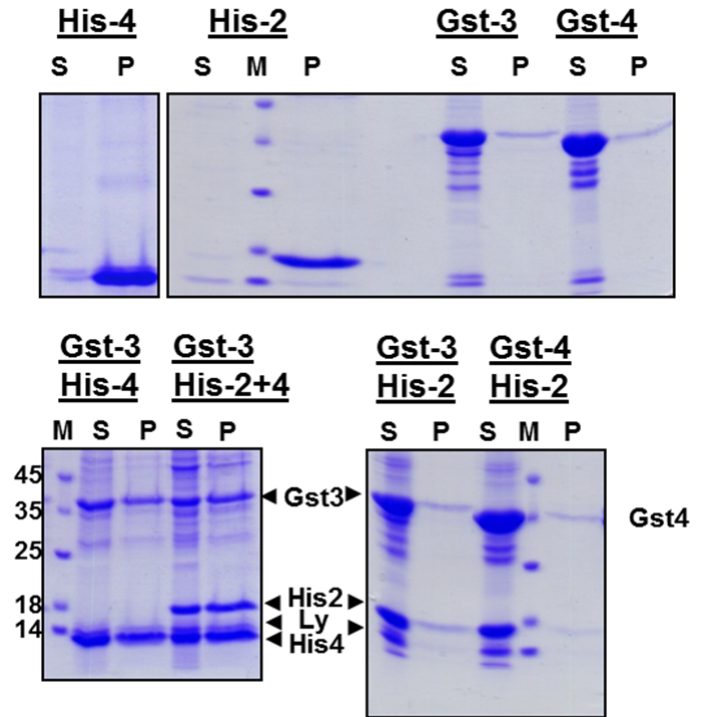
Figure 2. Refolding of EAV proteins during dialysis of urea-extracts of inclusion bodies. Upper panel: Dialysis of individual EAV-proteins. Lower panel: Combined dialysis of the indicated combinations of EAV-proteins. Inclusion bodies were resuspended in denaturating buffer. After centrifugation the resulting supernatants were dialyzed against buffer with decreasing urea concentration and finally against physiological buffer. The dialysate was then centrifuged and aliquots of the supernatant (S) and of the pellet (P) were analyzed by SDS-PAGE under reducing conditions and Coomassie-staining. M: molecular mass marker as indicated, Ly: Lysozyme. Due to the lack of antibodies we were not able to confirm the identiy of the bands by Western blot. Nevertheless, since the recombinant proteins are the major proteins present in bacterial lysates (see Figure 1), we are sure that the identification of bands is